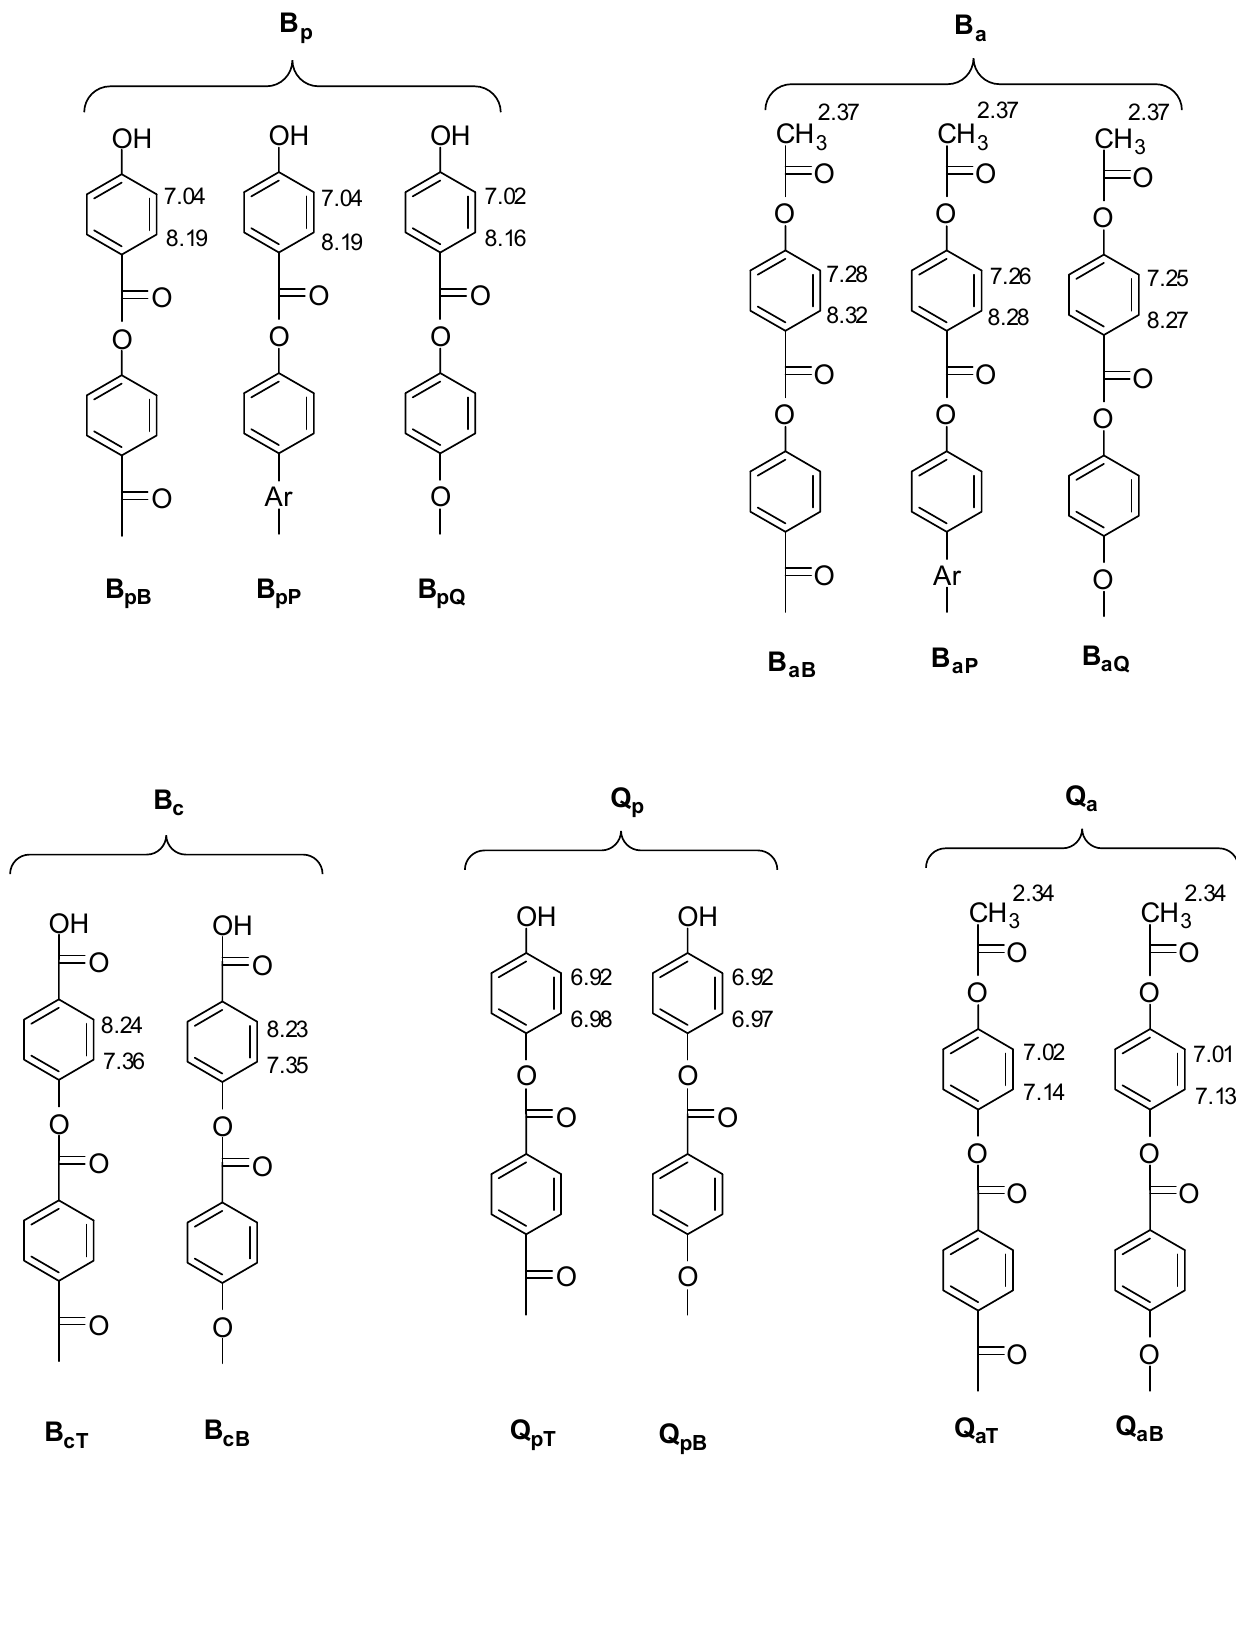
Table 8. 1 H chemical shifts of end groups of LCPs and cyclic LCPs in